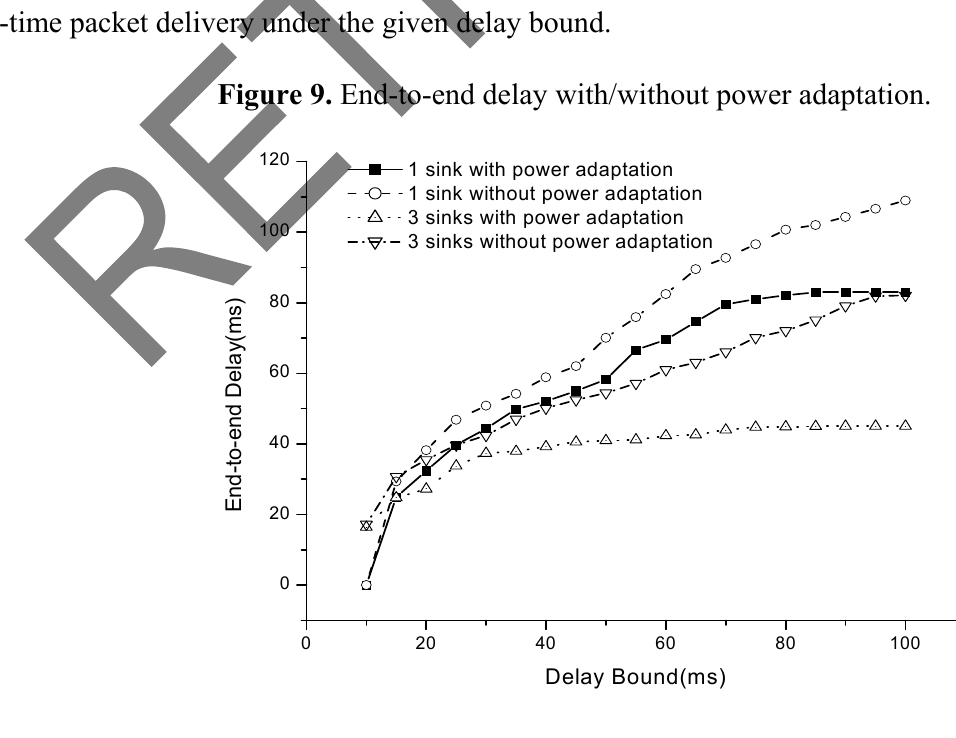
Figure 9. End-to-end delay with/without power